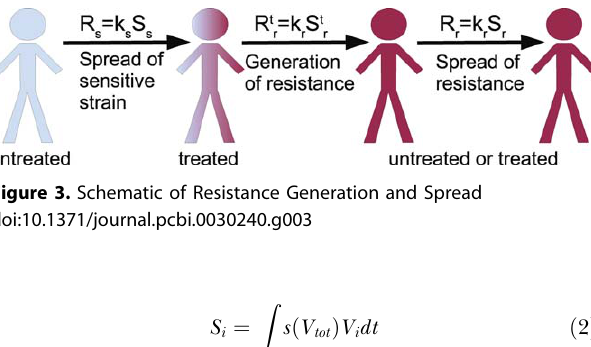
, for the TD Model r